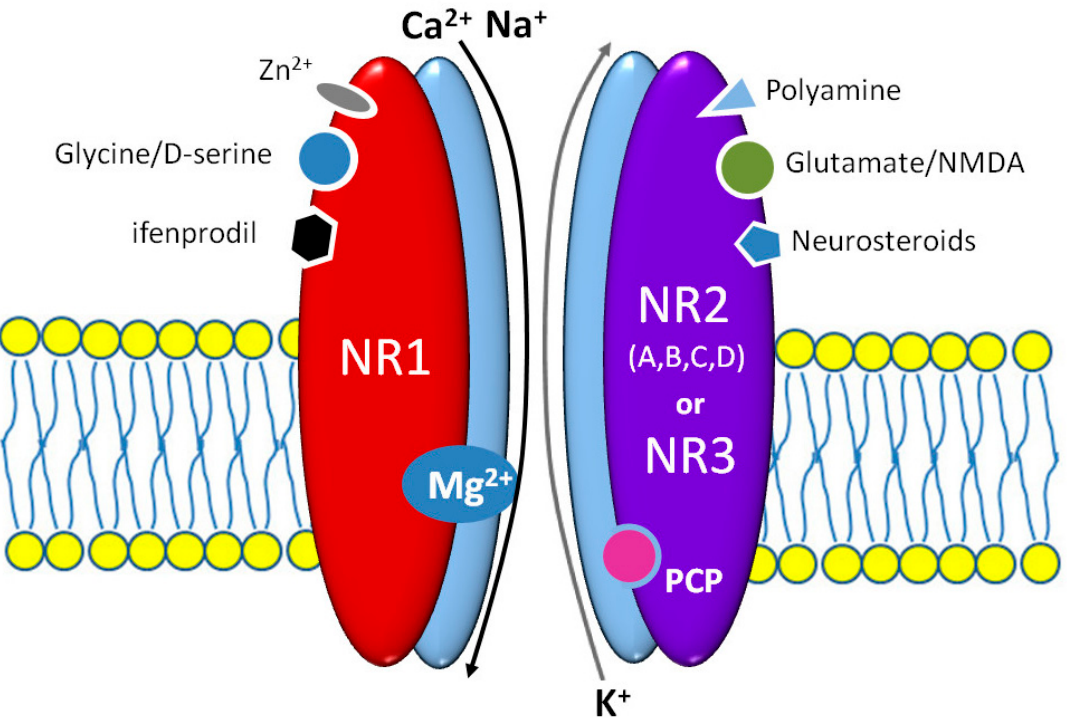
Figure 1. The scheme of N-methyl-D-aspartic acid (NMDA) receptor structure with its main binding sites in the context of an agonistic/antagonistic influence of the most important native and exogenous ligands.